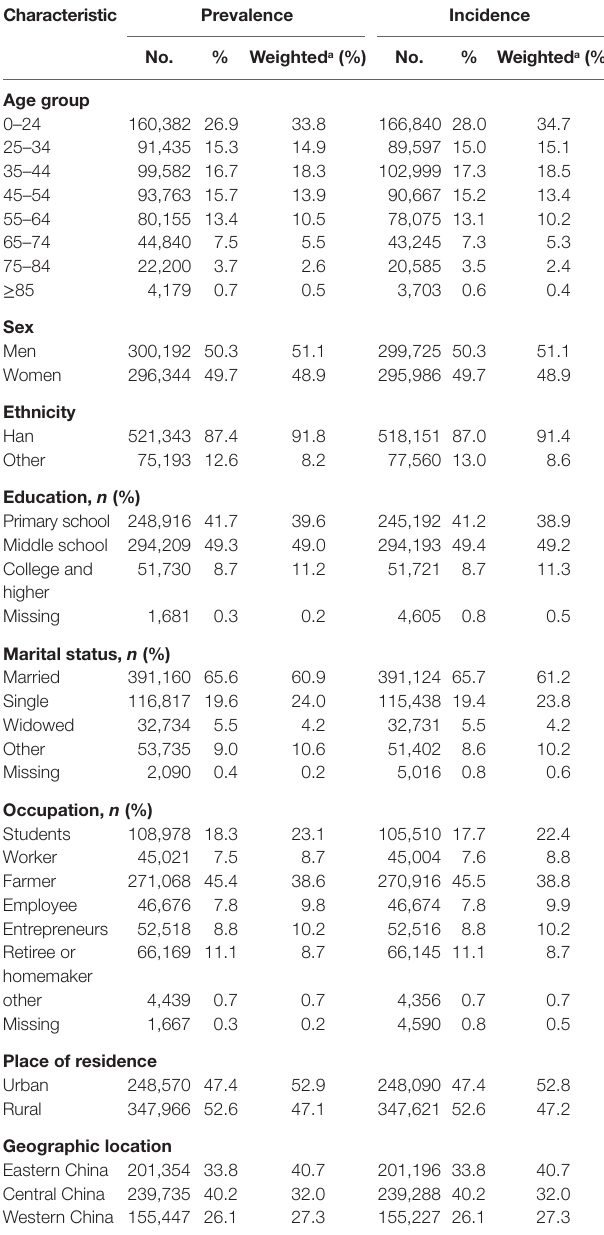
Table 1 | Characteristics of the study sample from the national epidemiological survey of transient ischemic attacks (TIAs) in China, 2013. characteristic Prevalence incidence no. % Weighted a (%) no. % Weighted a